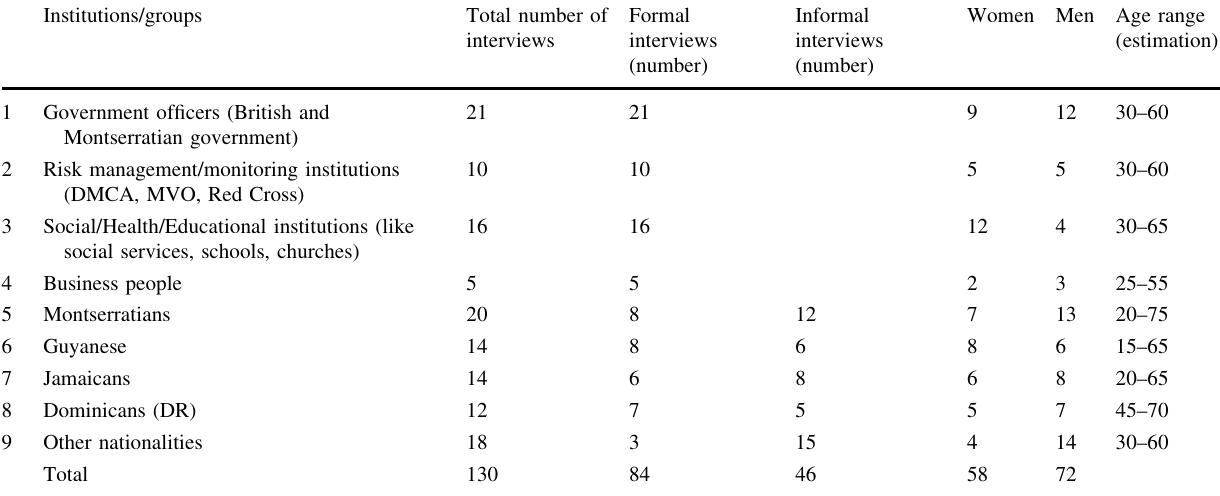
Fig. 2 Montserrat Hazard Level System Zones. Zones A and B are fully accessible. Zones C and F are accessible during daytime only. Zone V is fully restricted except for essential workers. Zones E and W are maritime zones, respectively with restricted access to essential workers and daytime access. Source: Montserrat Volcano Observa- tory and Disaster Management Coordination Agency (2014) Table 1 Interviews conducted between 2014 and 2017 in Montserrat. The members of risk management, social/health institutions, and business people (categories 2, 3, 4) were both Montserratians and non-Montserratians